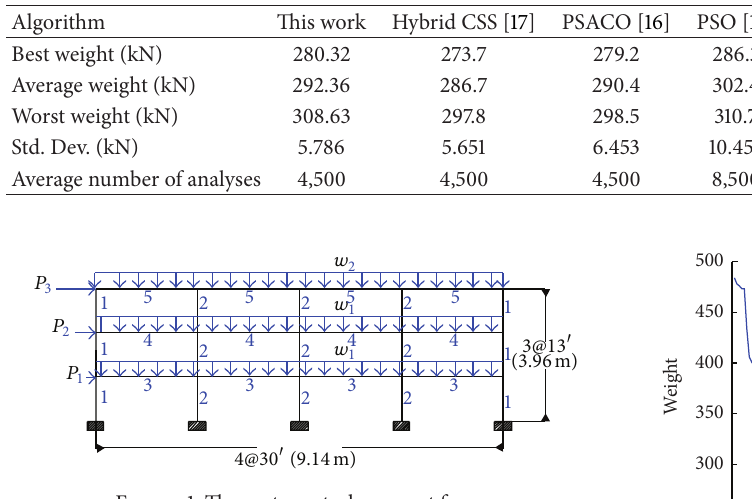
Figure 1: Three-story steel moment frame.